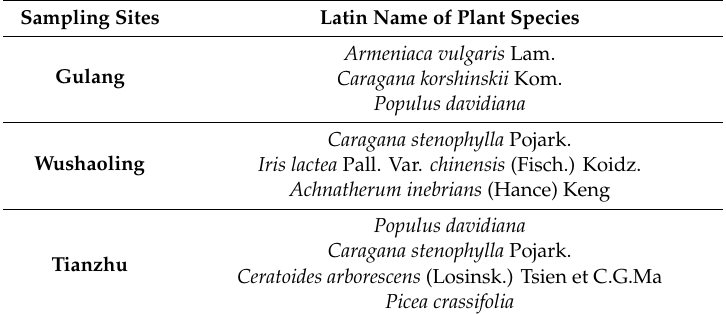
Table 9. Identification of the plant species collected in the Qilian Mountains in 2016. Sampling Sites